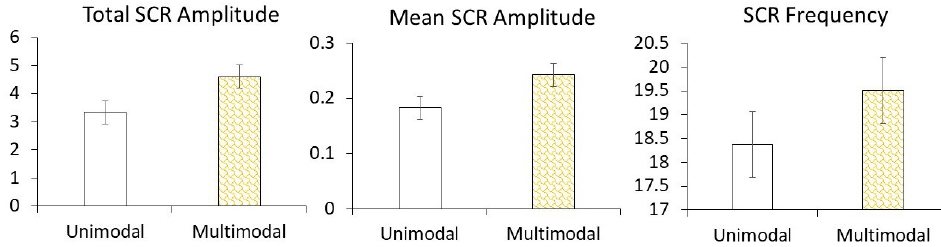
Figure 4. SCR (skin conductance responses) in the unimodal and multimodal conditions. Error bars represent two standard error units.